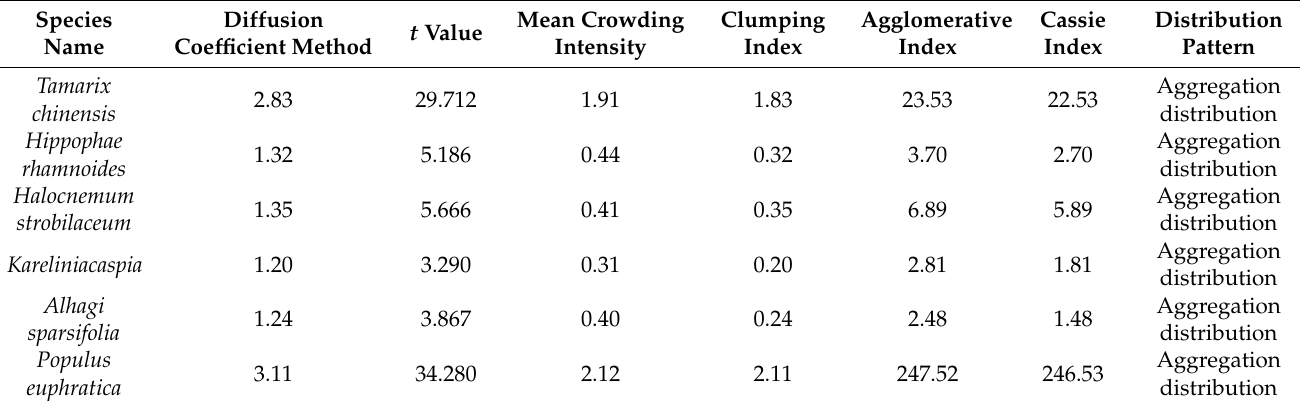
Table 3. Distribution pattern of dominant